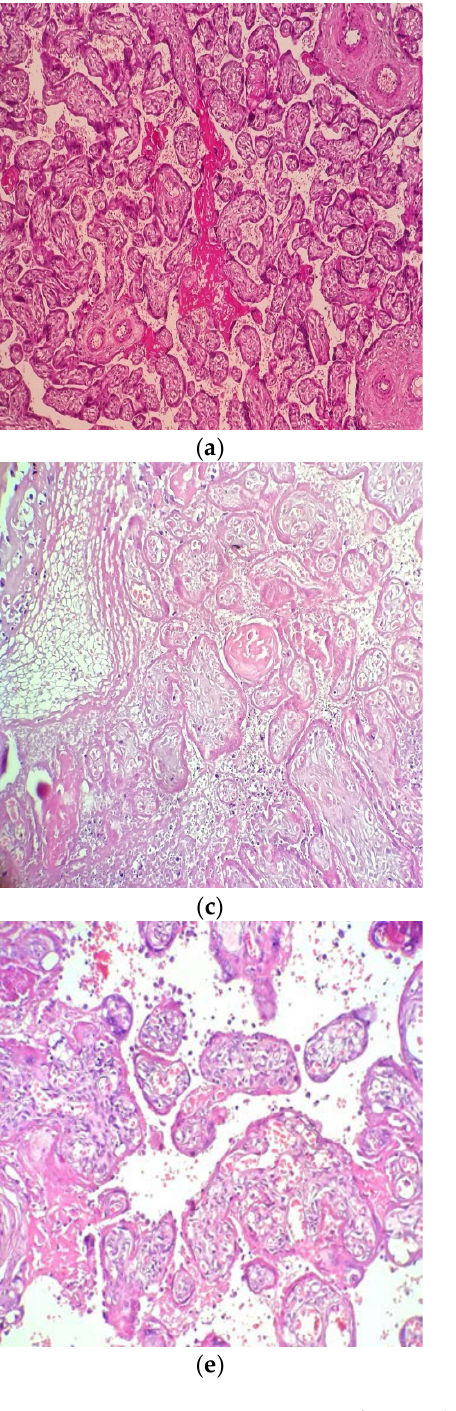
Figure 1. Microscopic aspects most frequently identified in placentas from SARS-CoV-2-positive pregnant women—Haematoxylin and Eosin staining, Leica DM750 Microscope. ( a ) Perivillous fibrin—10 × magnification; ( b ) Avascular villi—20 × magnification; ( c ) Villous infarction and necrosis— 20 × magnification; ( d ) villous oedema—20 × magnification; ( e ) Villitis—20 × magnification; ( f ) In- creased perivillous fibrin deposits and intervillous thrombosis—10 ×